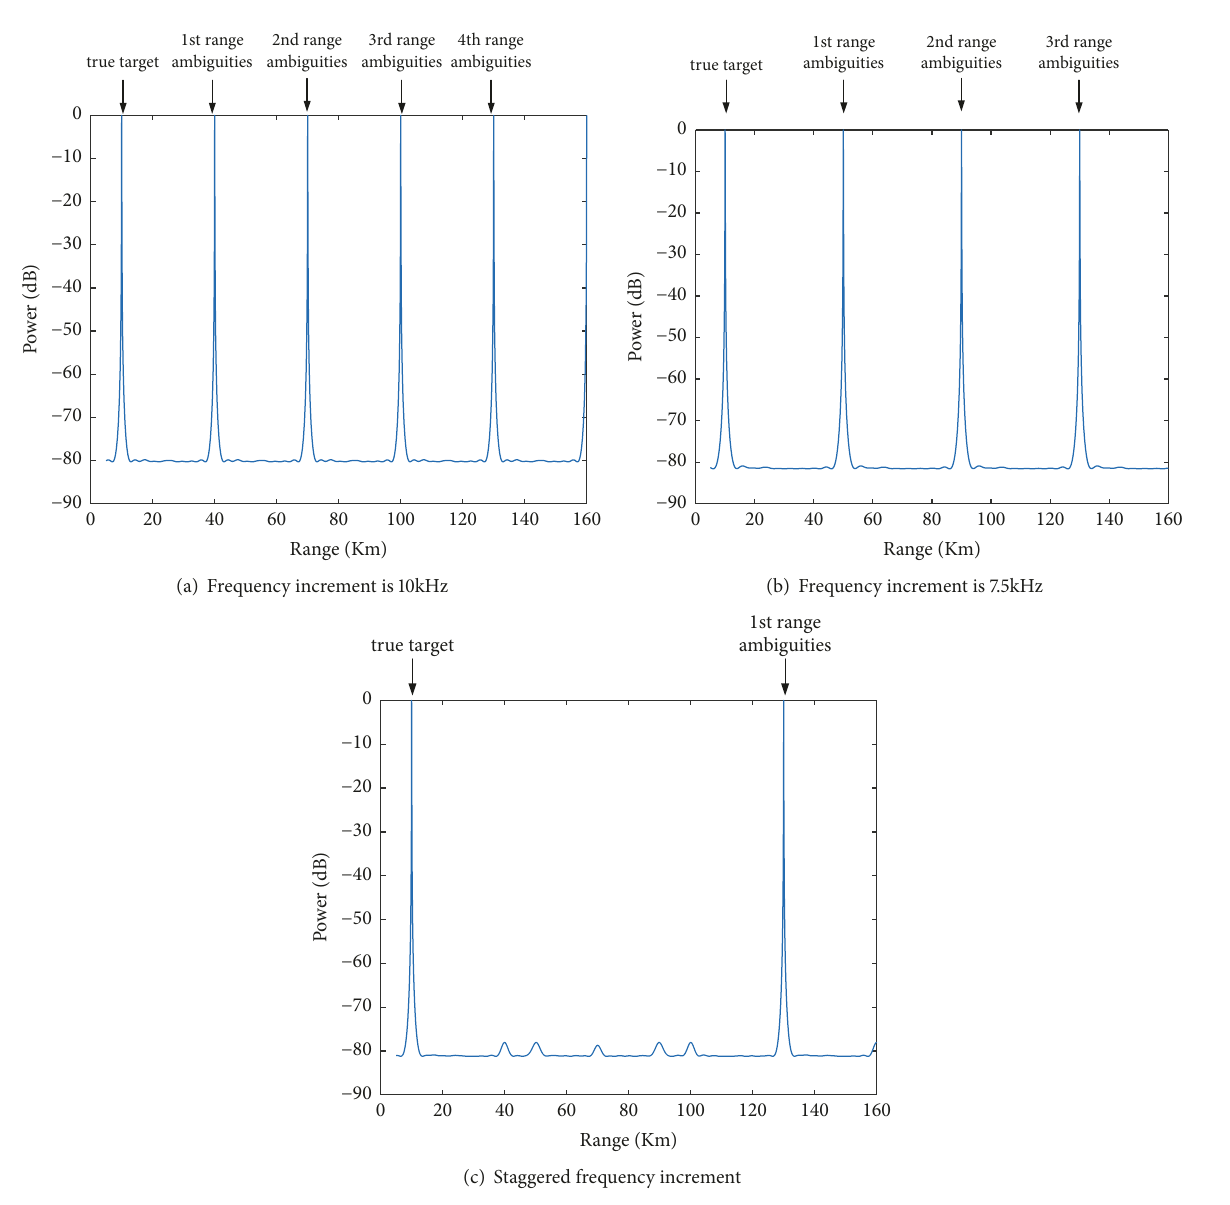
Figure 2: The estimated results of range spectrum with first